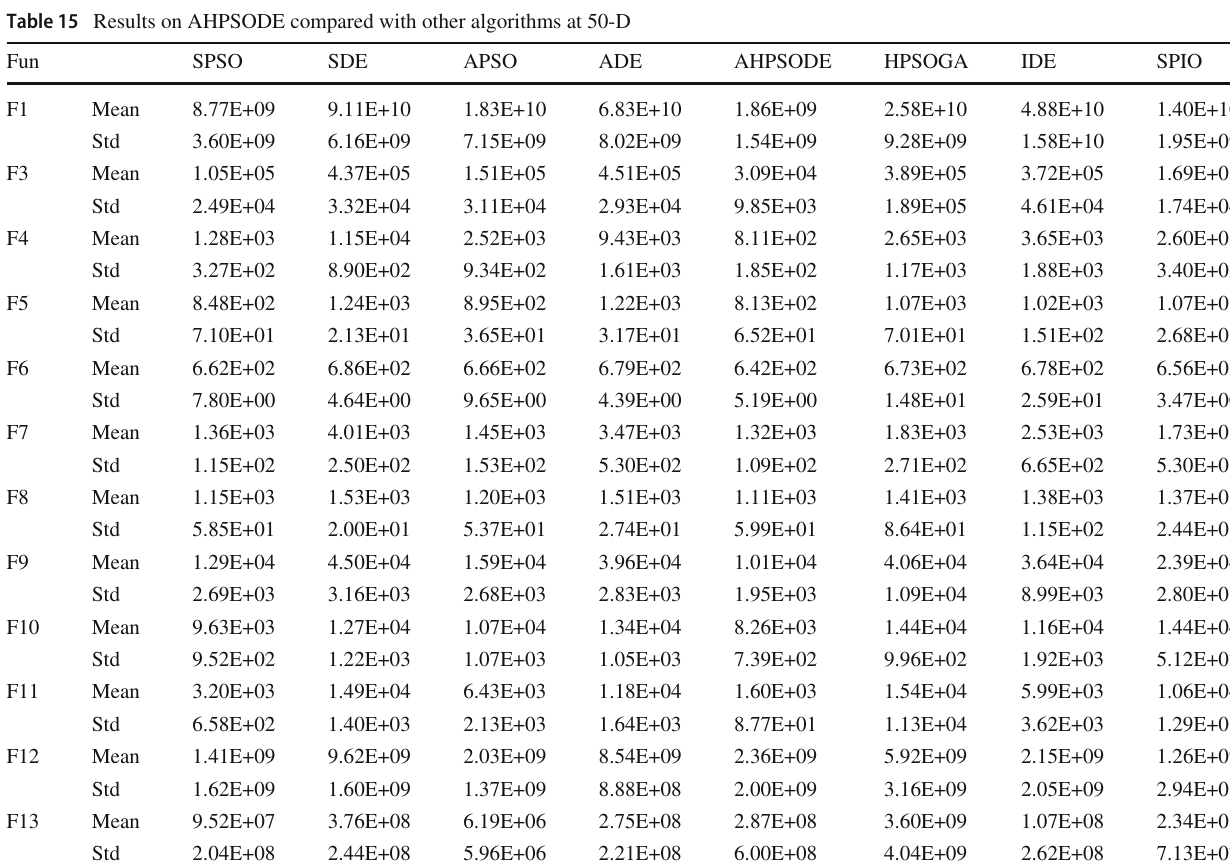
Table 15 Results on AHPSODE compared with other algorithms at